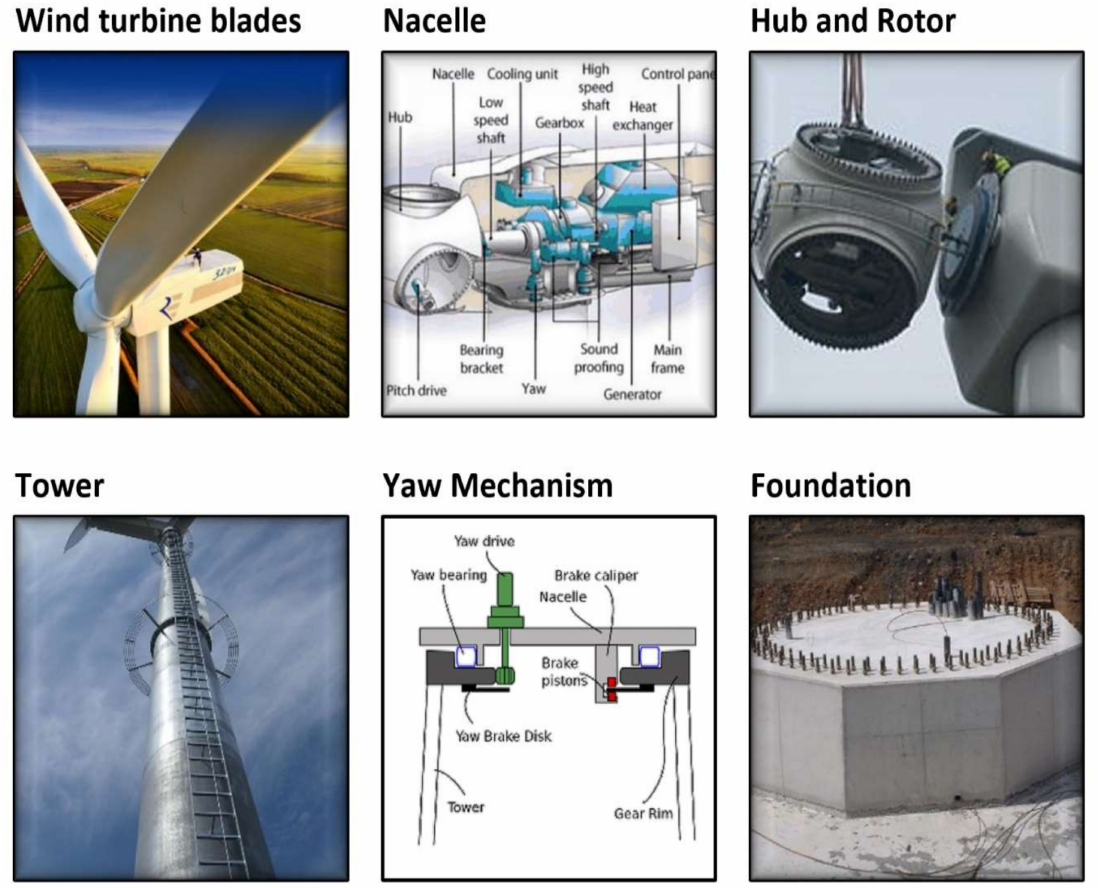
Figure 13. Major components of a wind turbine (adapted from